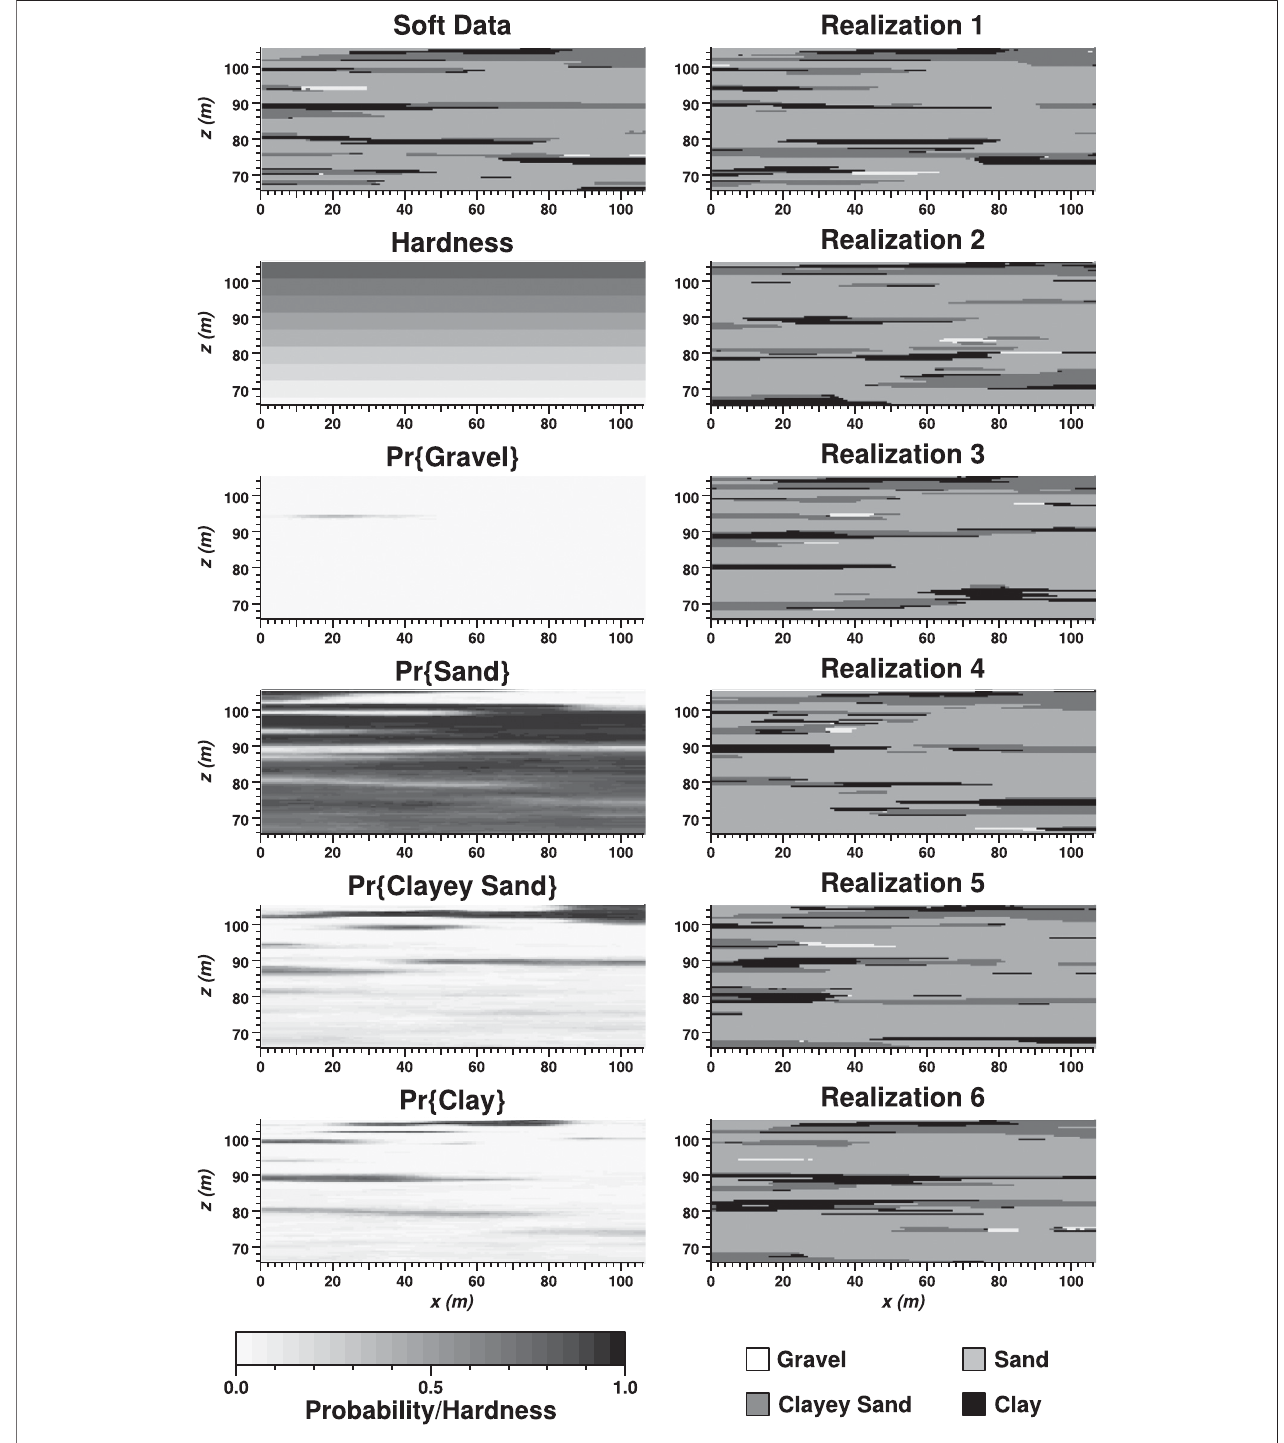
FIGURE 7 | Example using a realization as soft data (upper left) with hardness varying with depth (left, second from top) . Probability maps for gravel, sand, clayey sand, and clay facies (lower left) are derived from 100 realizations. The fi rst six soft-conditioned realizations are shown at right.